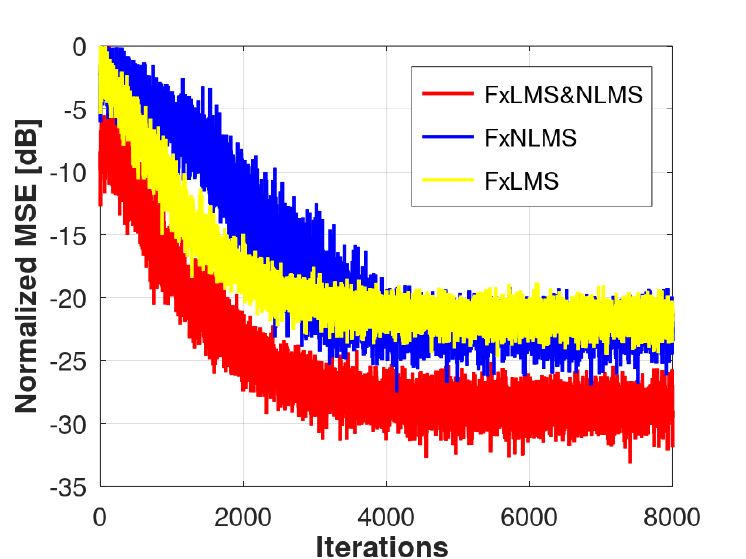
Figure 12. Comparison of the normalized MSE behavior averaged over 30 runs. Ragged curves (yellow): Monte Carlo simulation of Fx-LMS. Ragged curves (blue): Monte Carlo simulation of Fx-NLMS. Ragged curves (red): Monte Carlo simulation of Fx-LMS–NLMS.